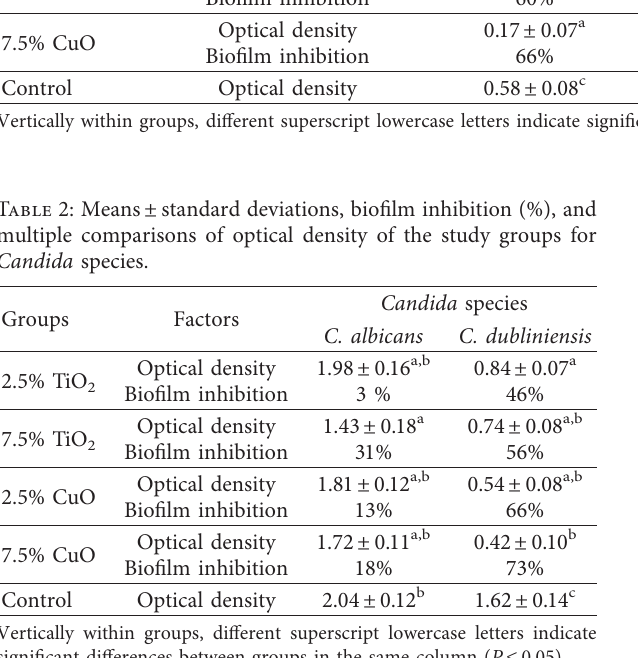
Figure 3: Means and standard deviations ( n � 5) of optical density of the study groups against different strains of Candida